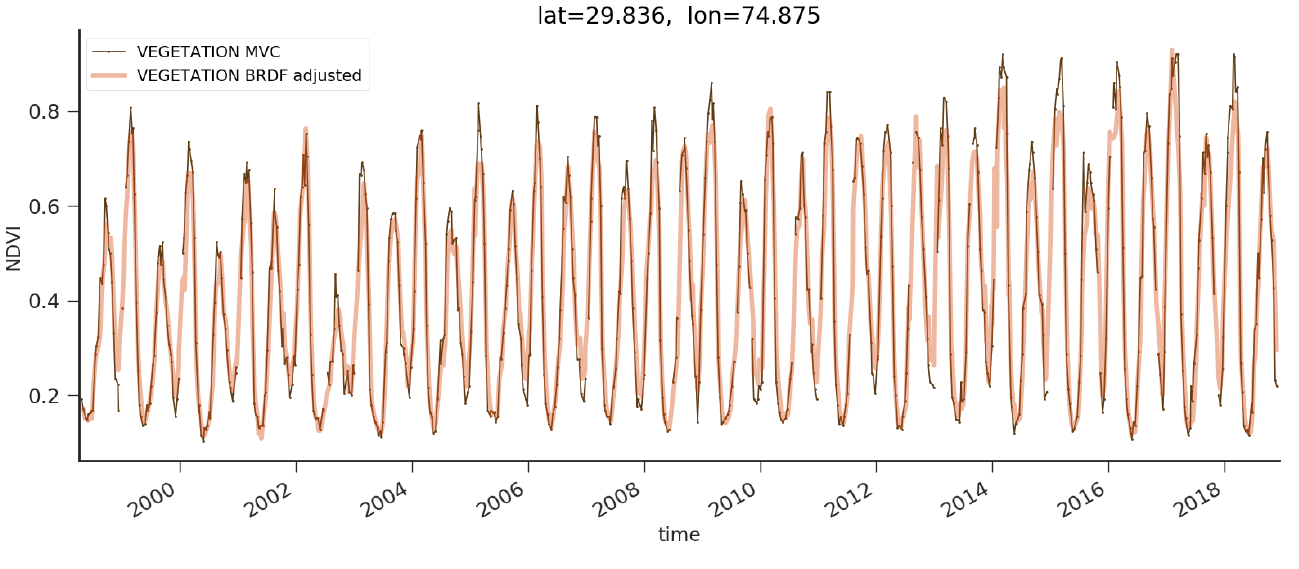
Figure 6. The layout is the same as in Figure 5 but for Belmanip 332 site